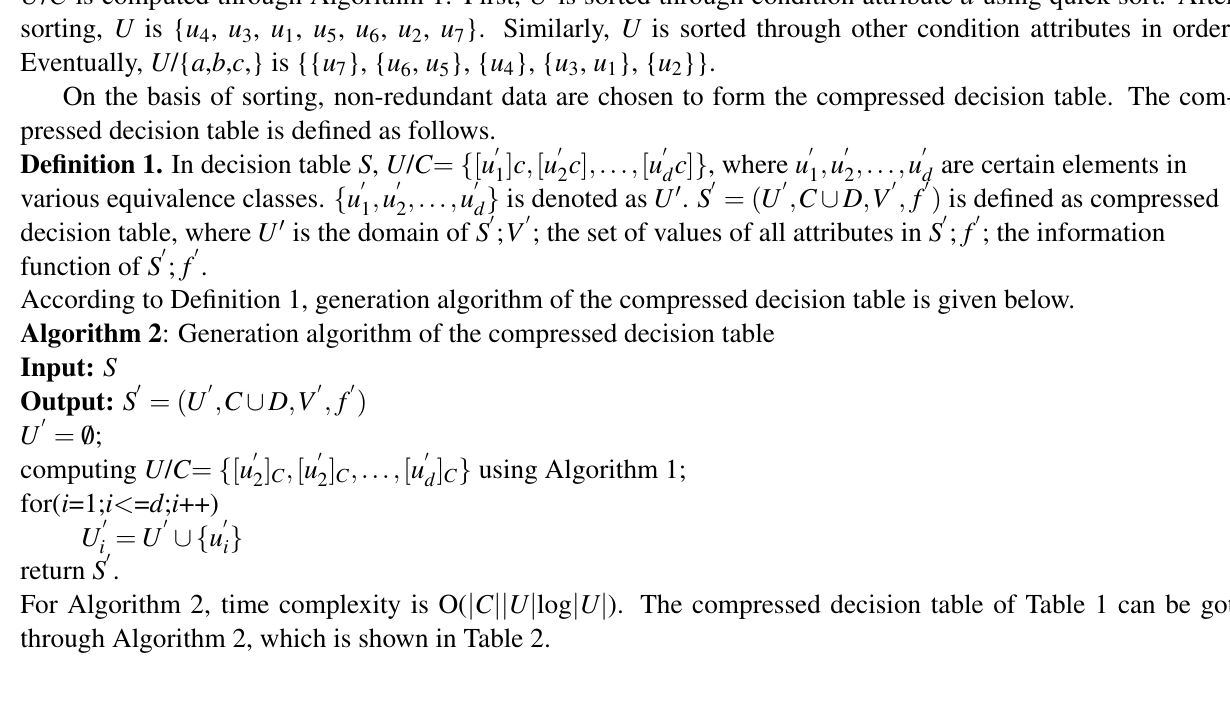
Algorithm 2 : Generation algorithm of the compressed decision